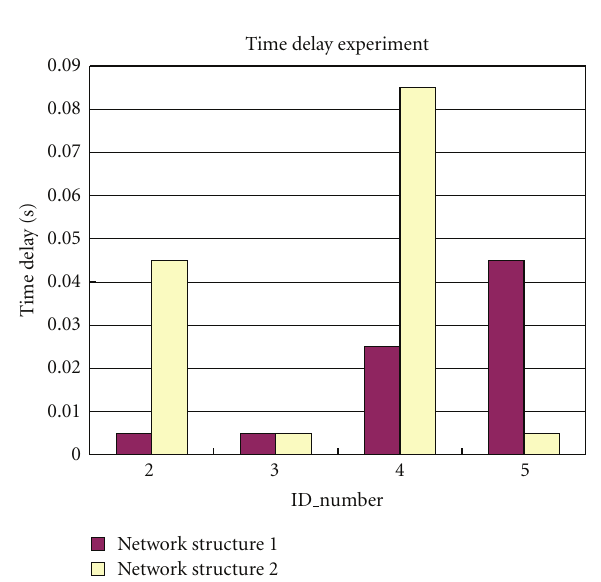
Figure 20: Experiment result of two-hop network.